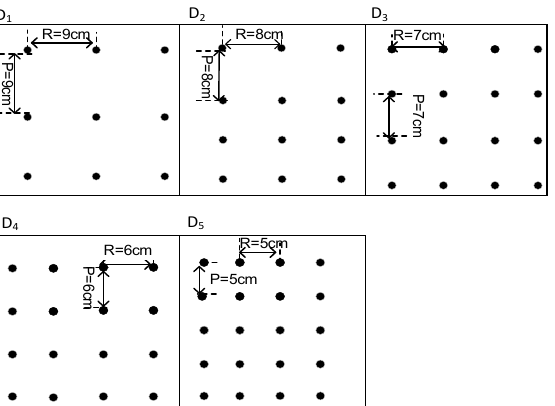
Figure 2. Schematic showing the planning patterns for the various densities: D 1 (9 cm), D 2 (8 cm), D 3 (7 cm), D 4 (6 cm), and D 5 (5 cm), with equal row and plant spacing.